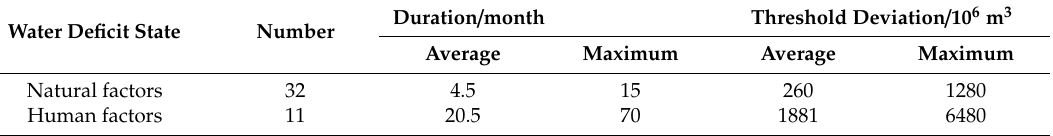
Table 4. Quantitative parameters in the human disturbance period (from 1976 to